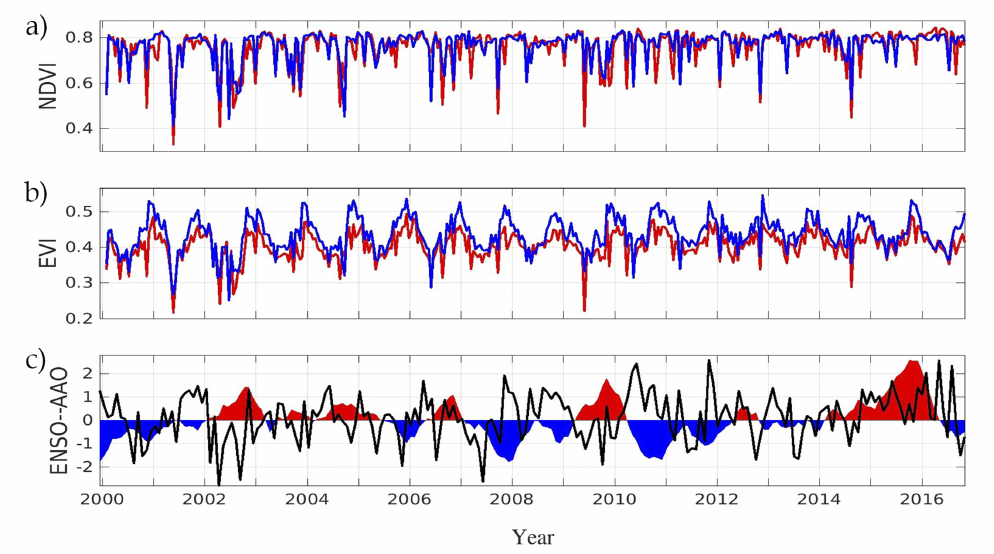
Figure 2. Time series of ( a ) NDVI for northern (solid red line) and southern (solid blue line) region; and ( b ) EVI for northern (solid red line) and southern (solid blue line) region region of CIS; ( c ) Climatic indices used in this study: an ENSO index represented as the monthly time series of El Niño 3.4 (positive/negative, red/blue) and the monthly series of the Antarctic Oscillation (AAO; black